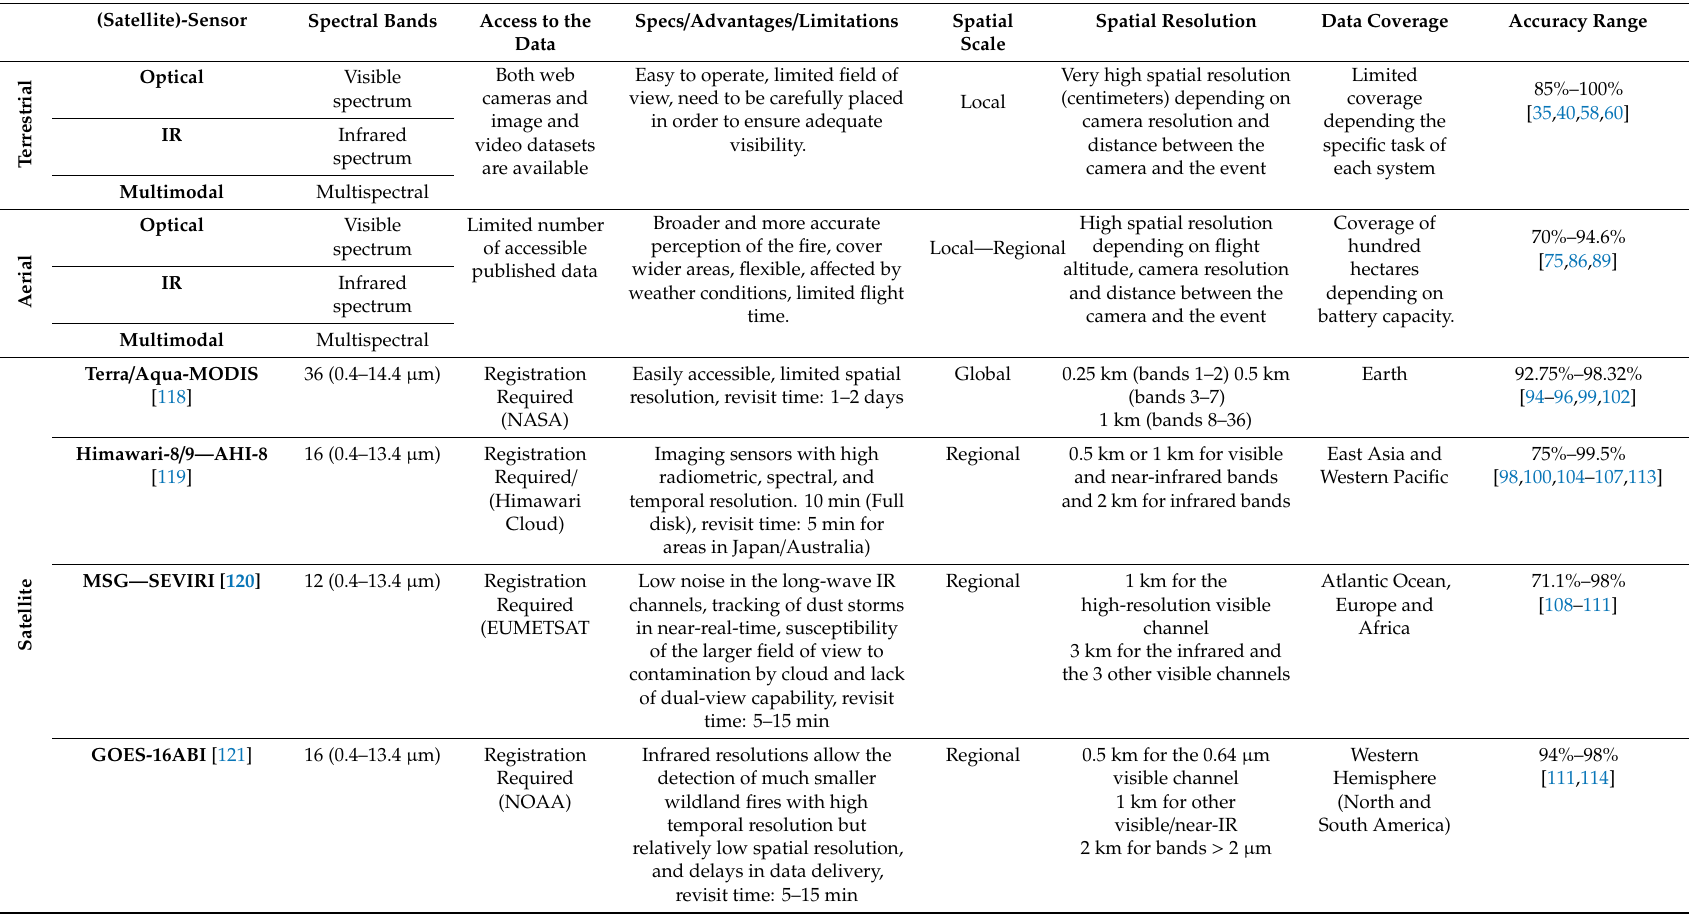
Table 1. Multispectral imaging systems and their